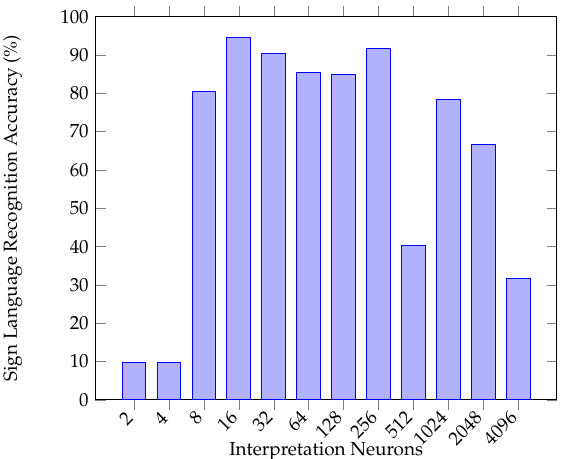
Figure 12. Multimodality 10-fold classification accuracy corresponding to interpretation neuron numbers towards benchmarking the late-fusion